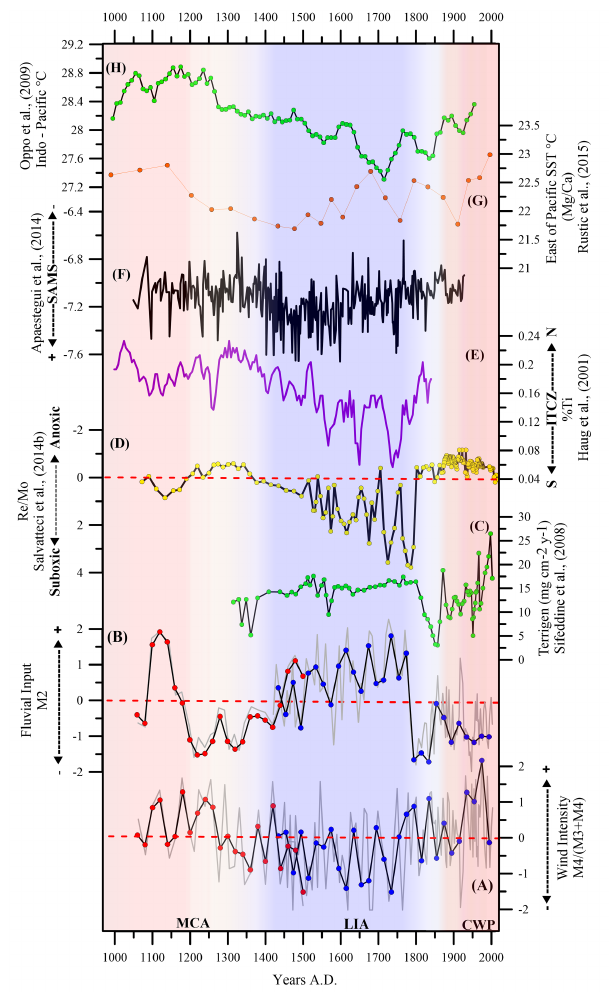
Figure 4. (a) Wind intensity (M4 / (M3 + M4)) anomaly recon- struction, (b) fluvial input (M2) anomaly reconstruction on the con- tinental shelf, and records of (c) terrigenous flux (total minerals) in Pisco continental shelf by Sifeddine et al. (2008), (d) OMZ activity (Re / Mo anomalies) negative values indicate more anoxic condi- tions (the axis was reversed) (Salvatteci et al., 2014b), (e) ITCZ mi- gration (%Ti) (Peterson and Haug, 2006), (f) SAMS activity recon- struction ( δ 18 O Palestina Cave) (Apaéstegui et al., 2014), (g) east- ern temperatures reconstruction (Rustic et al., 2015) and (h) Indo- Pacific temperatures reconstruction (Oppo et al.,